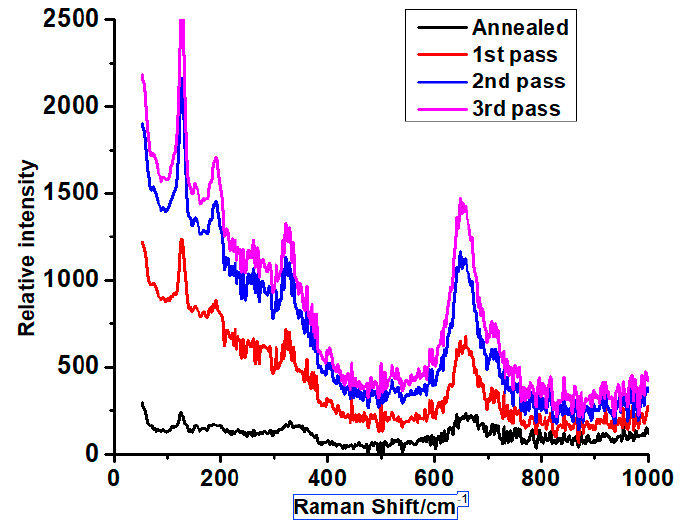
Figure 8. Raman spectroscopy plot of the as-received 5083 alloy in different solutions.